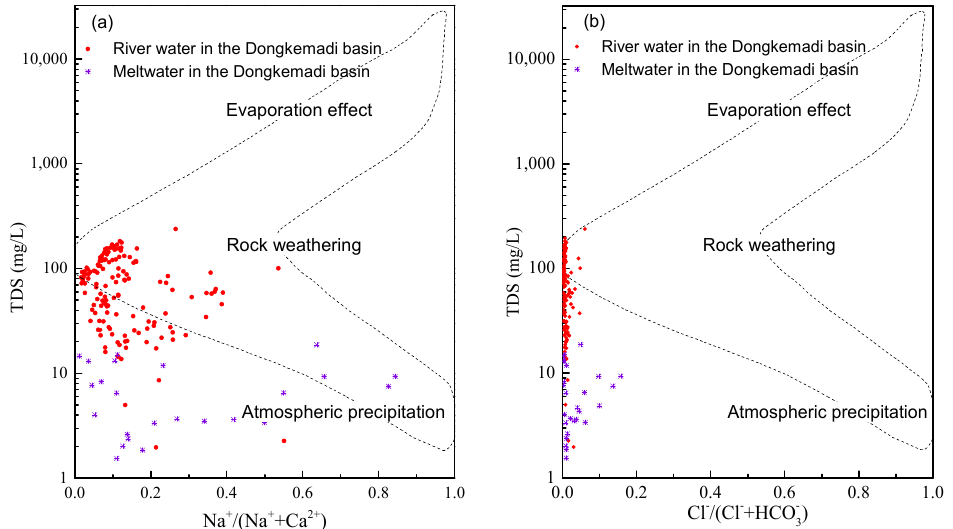
Figure 4. Gibbs diagram of the runoff of the Dongkemadi River. ( a ) the changes of the TDS and the ratios of Na + /(Na + + Ca 2+ ) in river water and meltwater; ( b ) the changes of the TDS and the ratios of Cl − /(Cl − + HCO 3 − ).